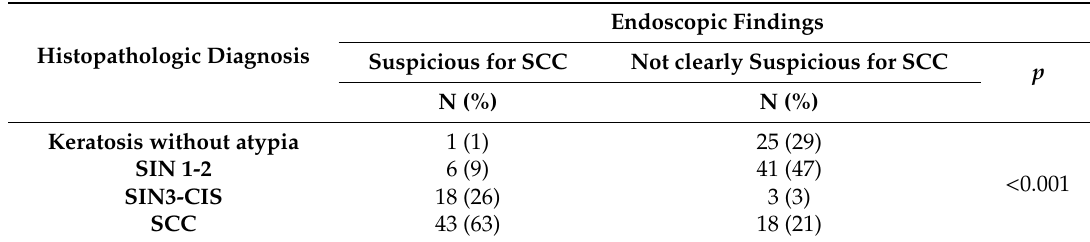
Endoscopic Findings